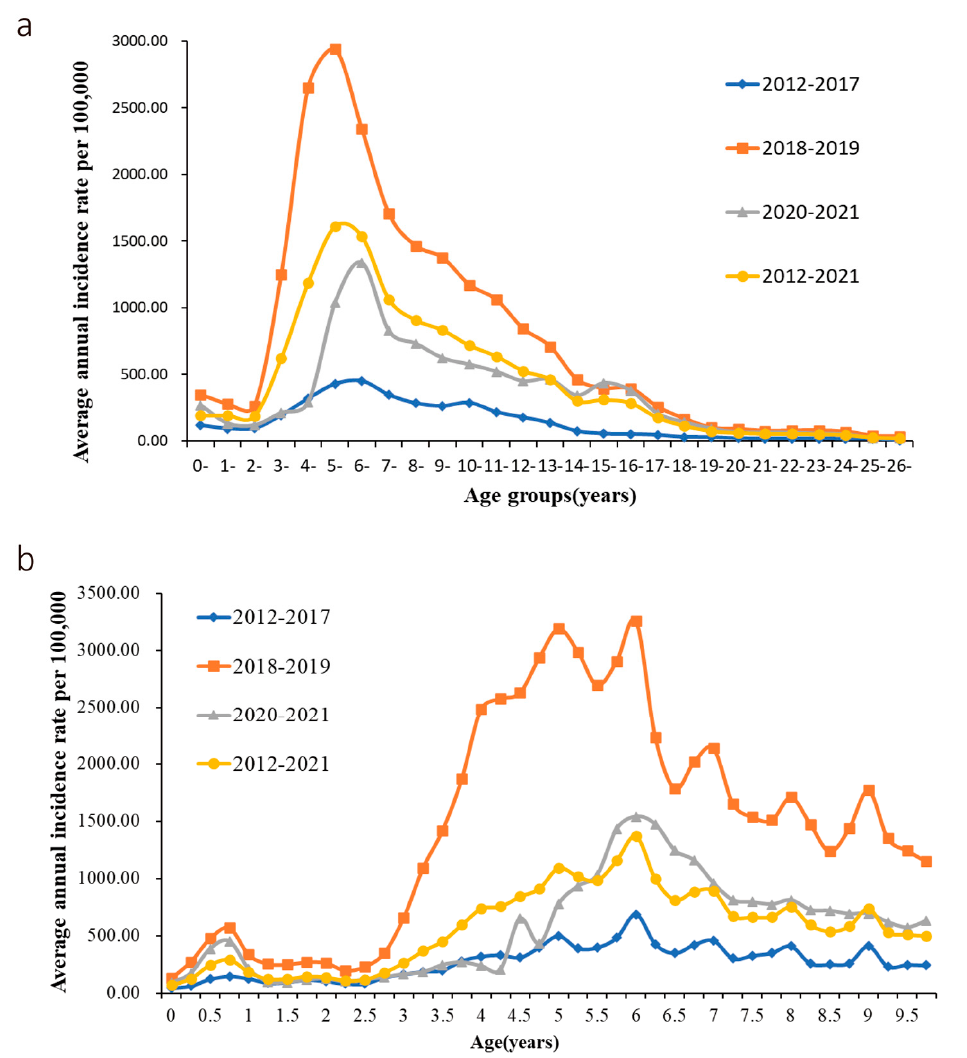
Figure 1. The age distribution of varicella incidences in Suzhou, 2016–2021. ( a ) Incidence of varicella in the whole population. ( b ) Varicella incidence among children aged < 10 years. Table 2. The incidence rates of varicella by district in Suzhou, China, 2012–2021. Average Incidence (per District